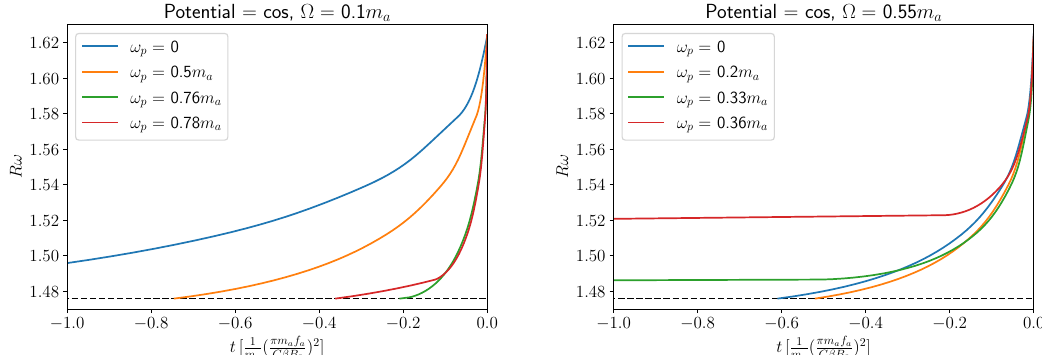
Figure 14 . Figures shows the product ωR as a function of time for the cos-potential for a few different values of the external magnetic field frequency Ω and the plasma frequency ω p . The dashed horizontal line shows the initial value for the same quantity. Time axis is chosen such that ω ( t = 0) = ω crit